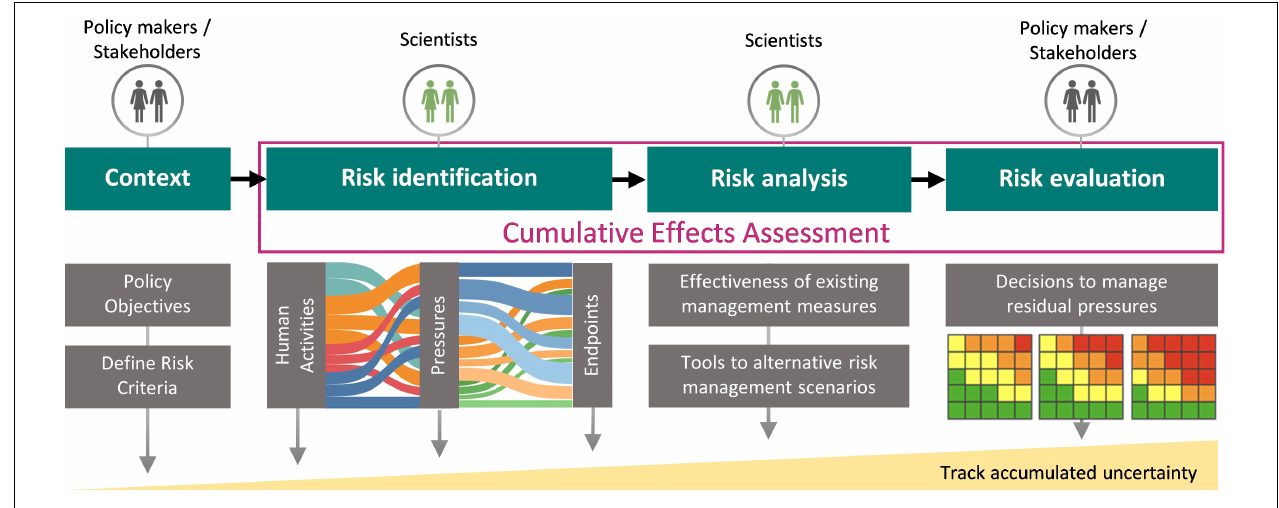
FIGURE 3 | Integrating Cumulative Effects Assessments (CEA) into a risk management process. CEA consists of the three basic steps of risk identification, risk analysis, and risk evaluation. Modified from Stelzenmüller et al. (2020).